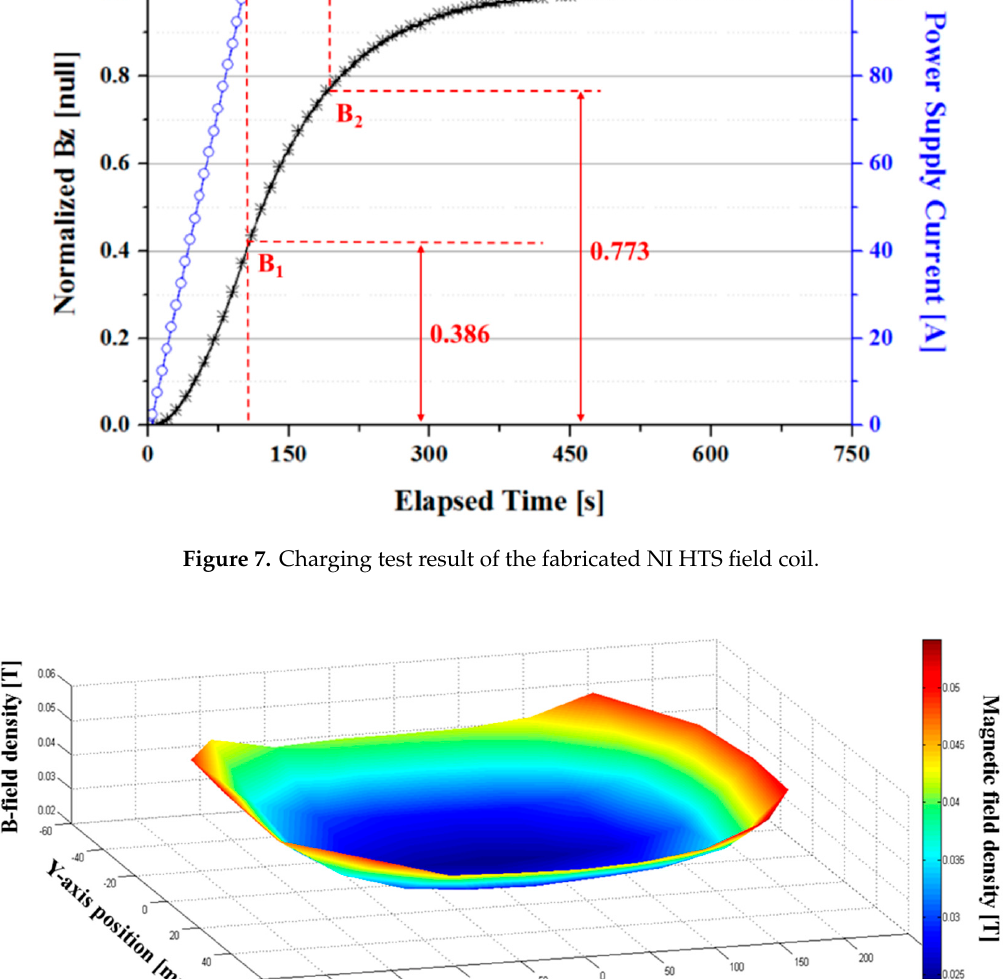
Figure 6. ( a ) Pictures of the fabricated NI HTS field coil, and ( b ) test set-up.